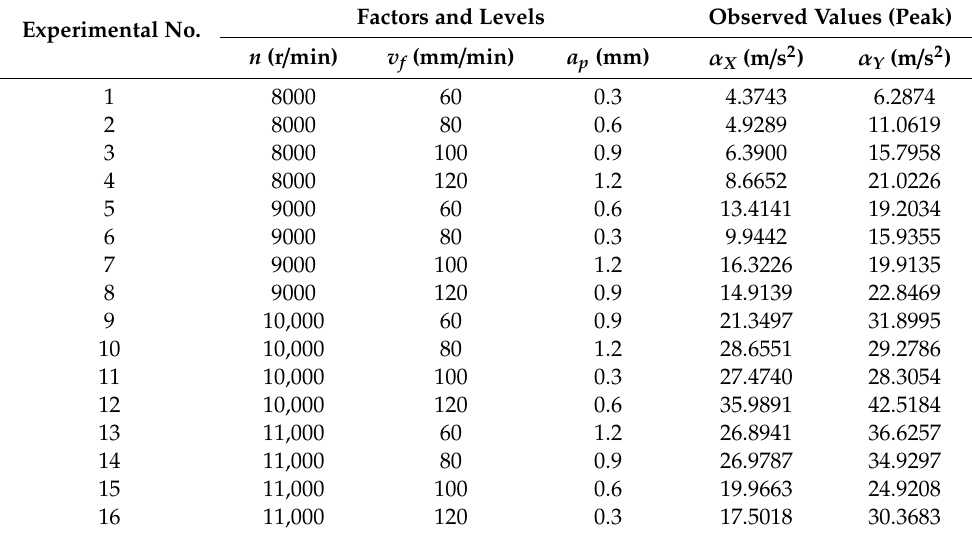
Table 3. L 16 orthogonal matrix and peak observed values of